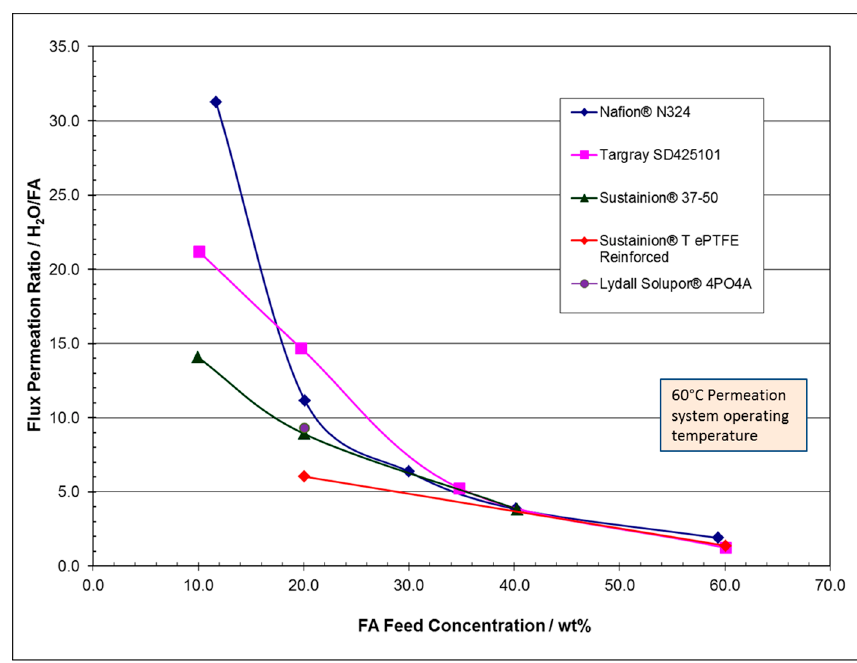
Figure 4. Graphical plot of the individual membrane H 2 O/FA mass permeation flux ratios as a function of the FA wt% concentration taken from the data in Table 5 at a permeation system operating temperature of 60 °C.